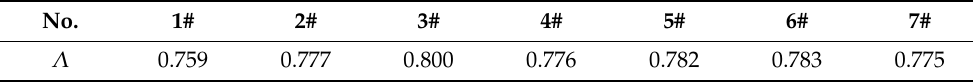
Table 6. Optical basicity of the experimental slag.